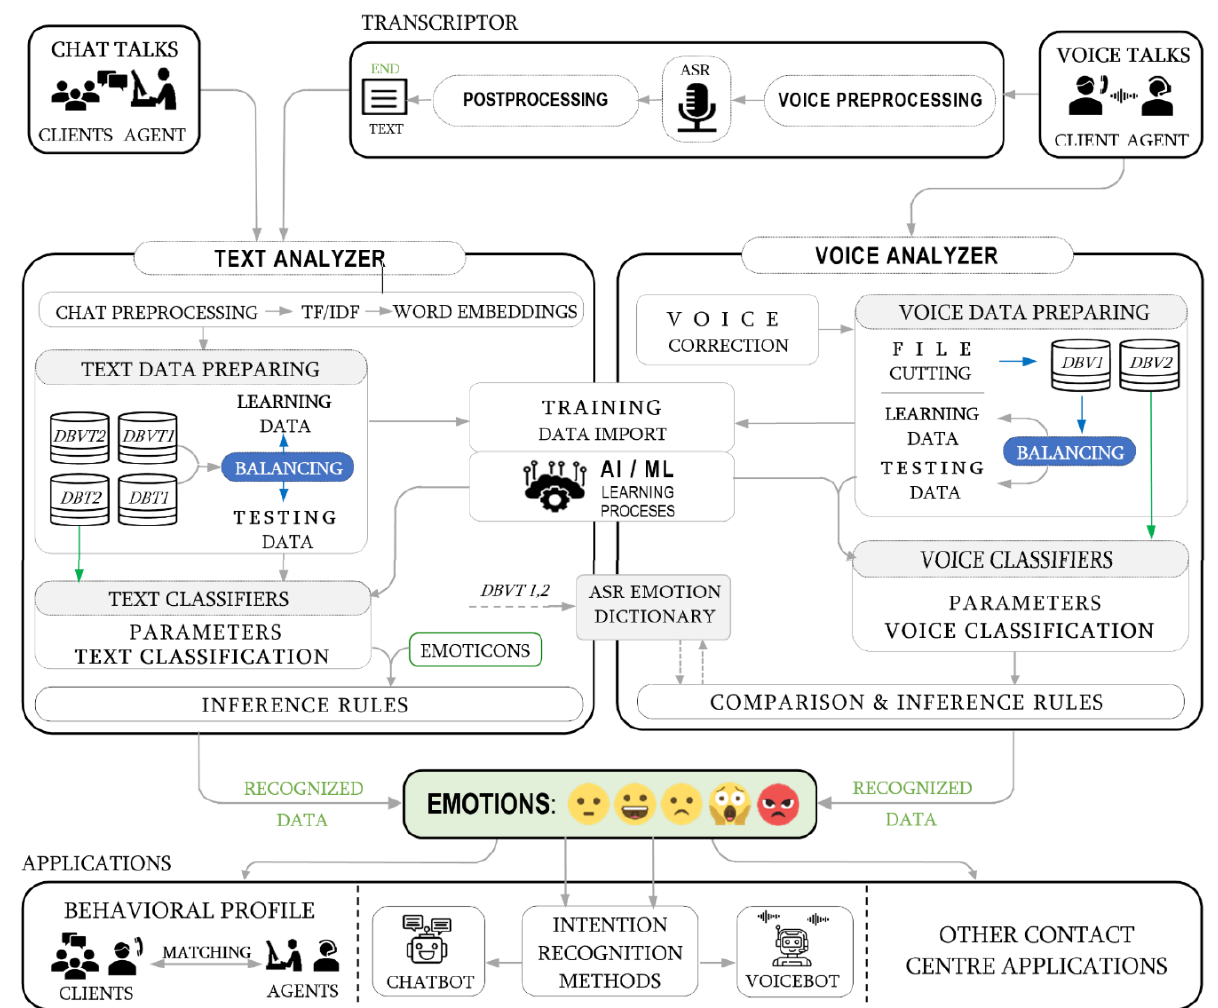
Figure 4. Method for emotion recognition in text and voice channels of CC systems.